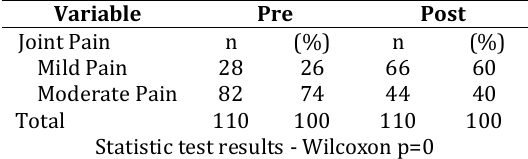
Table 2. Effect of Ergonomic Gymnastics on